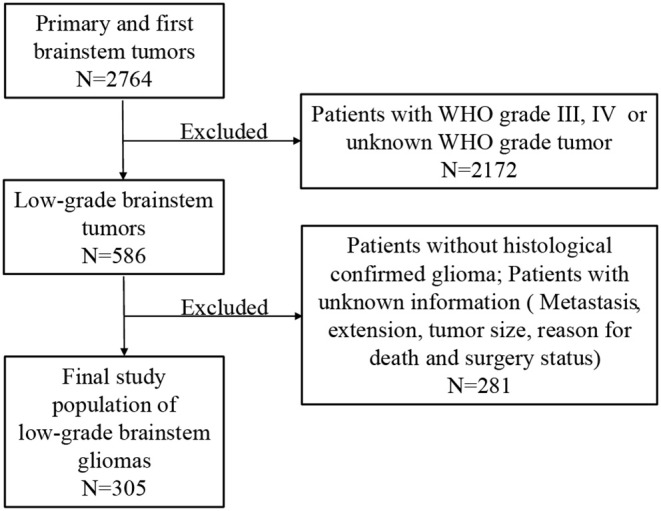
Flowchart of low-grade brainstem glioma patient selection.